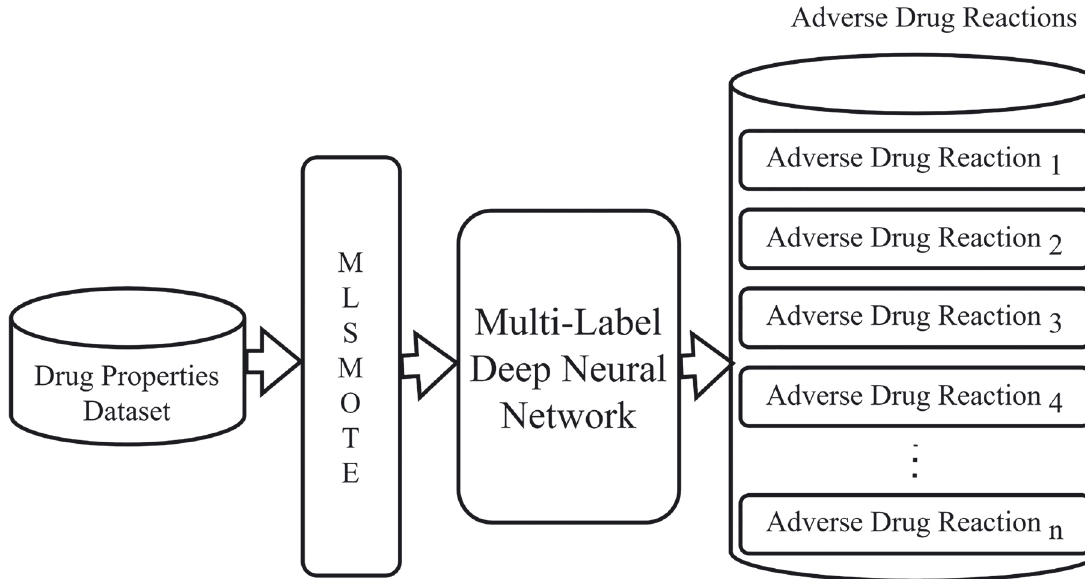
Figure 2: Architecture of the proposed methodology for ADR